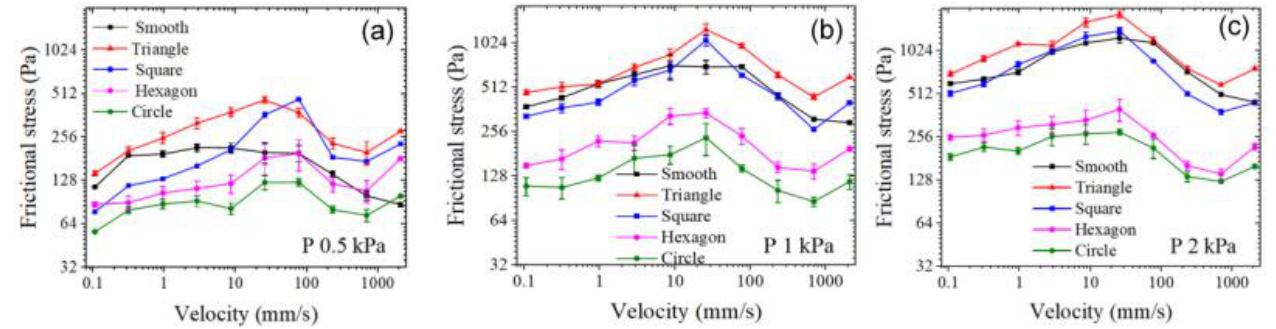
Figure 7. Frictional-stress variation on hydrogel surfaces containing different micro-pits when the titanium alloy served as the substrate. ( a ) P = 0.5 kPa, ( b ) 1 kPa, and ( c ) 2 kPa. Under contact pressure P of 0.5 kPa, frictional stress on the triangular micro-pit sur- face was the highest (143 – 463 Pa) throughout the sliding-velocity range. Frictional stress on the quadrilateral micro-pit surface (77 – 469 Pa) began to exceed frictional stress on the smooth-surface when v > 8.7 mm/s. Frictional stress was the lowest for hexagonal (87 – 197 Pa) and circular (56 – 124 Pa) micro-pit surfaces, and in both cases, was lower than smooth- surface frictional stress.